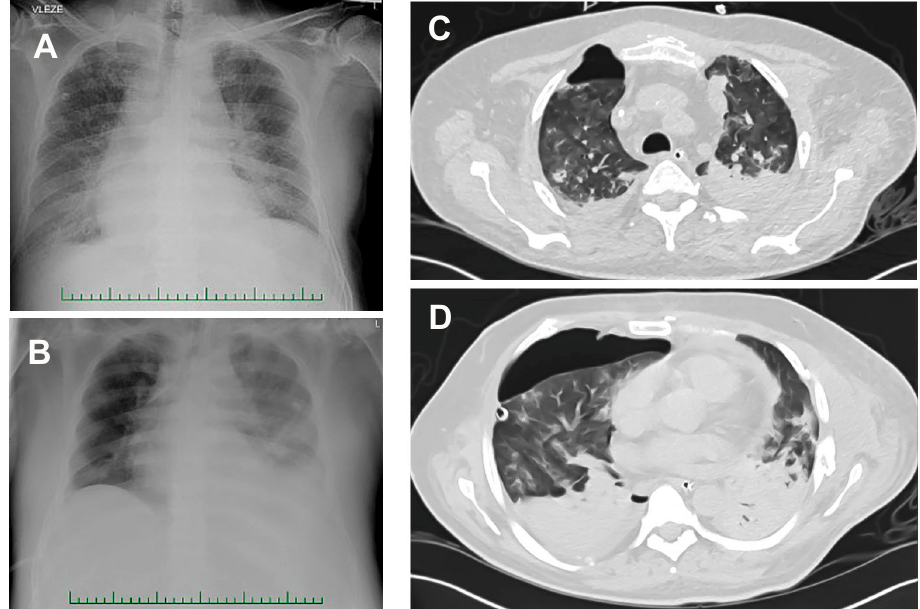
Figure 1. ARF patients’ chest radiography and CT scans. ( A , B ) Radiographs showing increasing bilateral, inhomogeneous blurring, likely caused by inflammatory infiltrations (Patient 1). ( C , D ) Atelectasis in both lower lung lobes and irregular multiple ground glass opacities revealed by the CT scan of Patient 2. Right-sided pneumothorax and small amount of fluid in bilateral pleural cavities are also discernable.